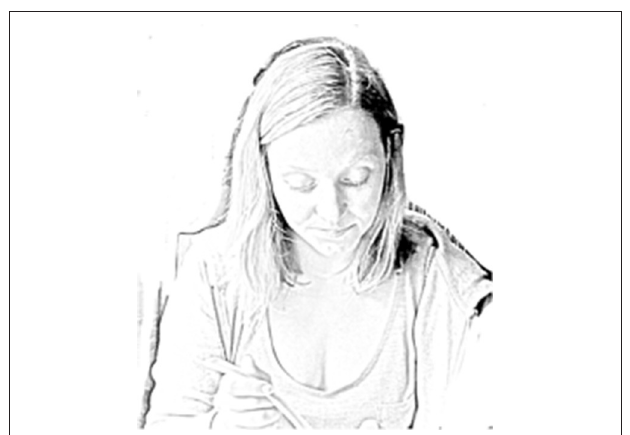
FIGURE 1 | Image published with the written informed consent of the depicted adult.